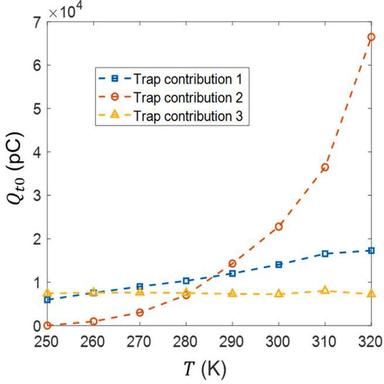
Evolution of Qt0 of each contribution obtained after the optimization of the data with the temperature.